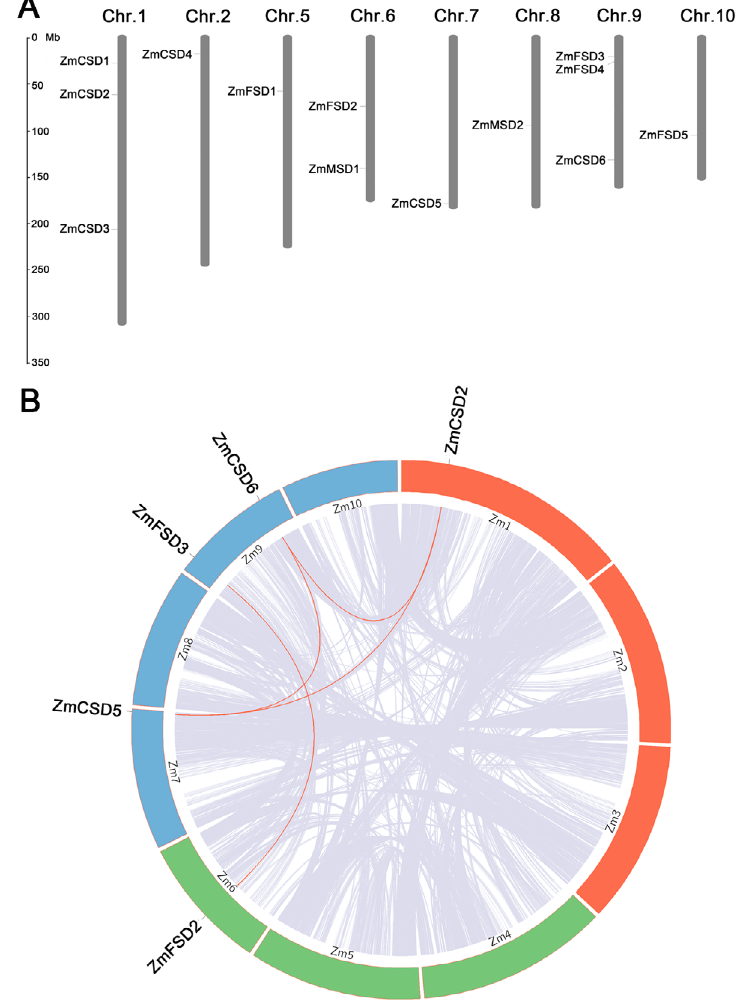
Figure 4 ‒ Chromosomal locations and syntenic analysis of the ZmSOD genes.A. Chromosomal locations of the 13 ZmSODs . B. Synteny and gene duplication analysis among ZmSODs in the maize genome.